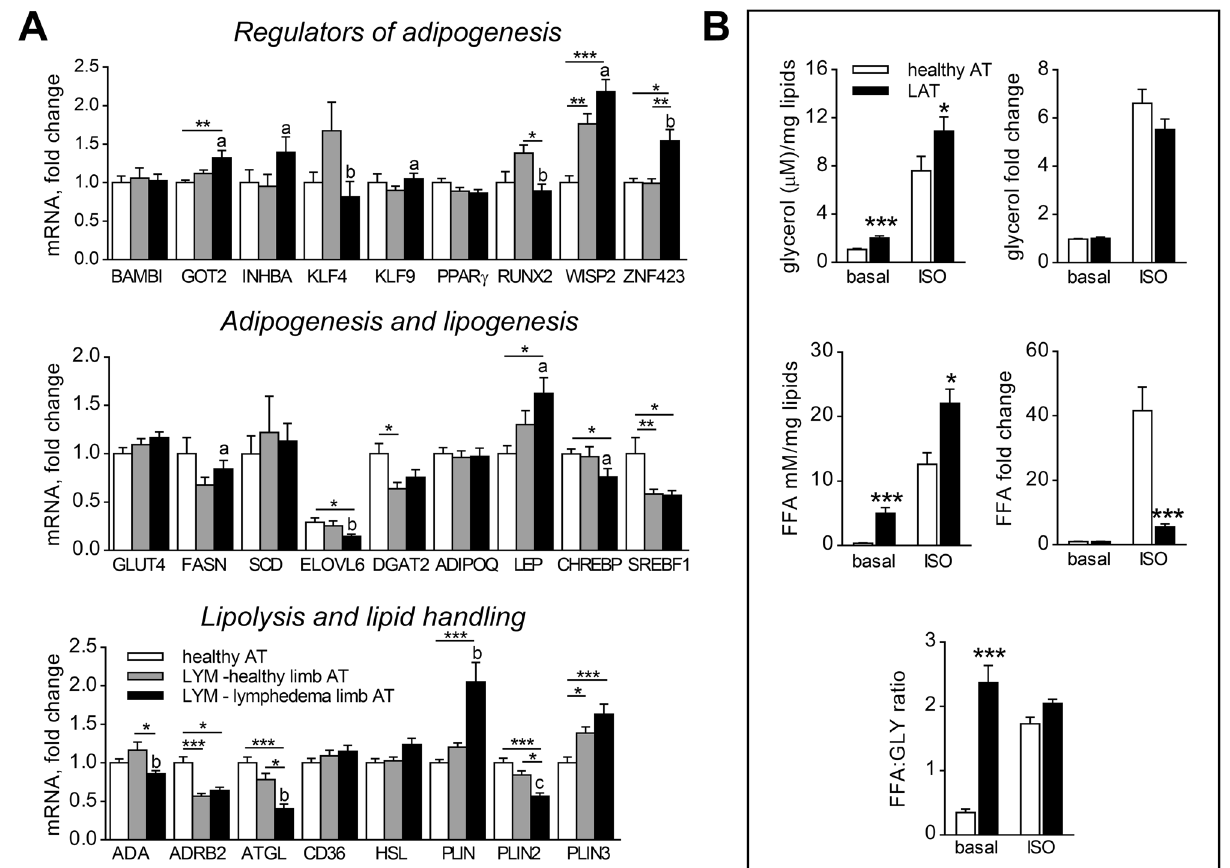
Figure 2. LAT qualities related to adipocytes. ( A ) mRNA levels of markers of adipogenesis, lipogenesis and lipolysis in whole AT expressed as fold change over the mean expression of healthy group (Kruskal–Wallis test of 2 ΔCt values, Dunn’s correction, comparison of 3 groups, *p < 0.05, **p < 0.01, ***p < 0.001; Wilcoxon test of paired healthy and diseased limb of LYM subjects, a- p < 0.05, b- p < 0.01, c- p < 0.001). ( B ) Ex vivo lipolysis in AT explants. Cells were exposed to basal conditions or 1 µM isoproterenol (ISO) for 4 h. Concentrations of glycerol and FFA normalized to mg of lipids and fold change over the basal conditions are shown (Two-way ANOVA of LN transformed data, Sidak post-hoc analysis, *p < 0.05, ***p <